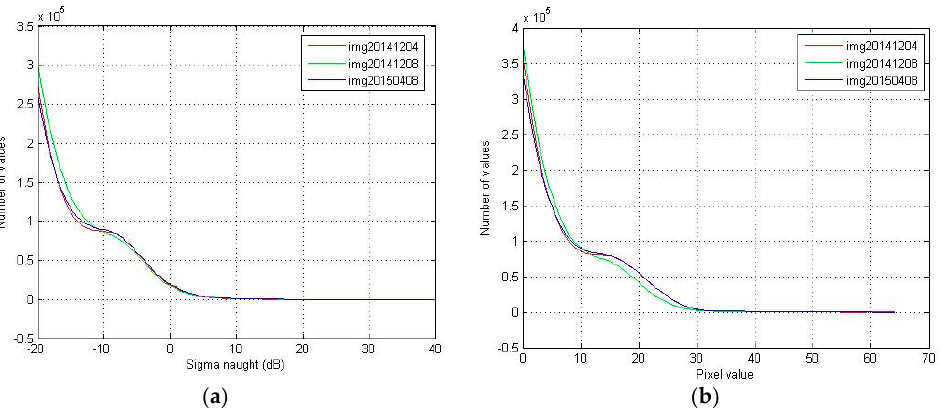
Figure 10. Histograms of ( a ) sigma naught of the SAR image and ( b ) 64-level quantization image by ENVI.